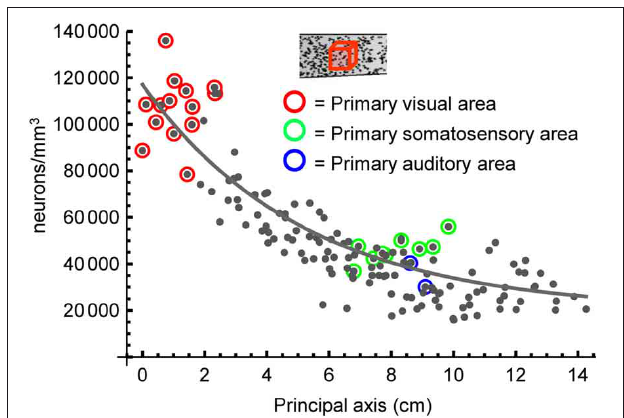
FIGURE 7 | Highlighting primary sensory areas in baboon. Fitting all data points with a one-factor model (as described in the text) yielded the black curve. A two-factor model (not illustrated, see text) suggests primary sensory areas (those highlighted here) have an expected density 1.26 times greater than would a non-primary area in the same location.